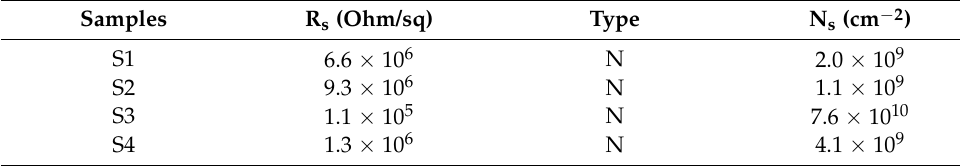
Figure 5. A shamanic diagram representing the fabricated device ( a ) and the relation between R s and N s of MoO 3 /Si of the S1, S2, S3, and S4 samples ( b ). N s of MoO 3 /Si of the S1, S2, S3, and S4 samples ( b ). Table 1. Shows the surface sheet resistance (R s ) and sheet carrier concentration (N s